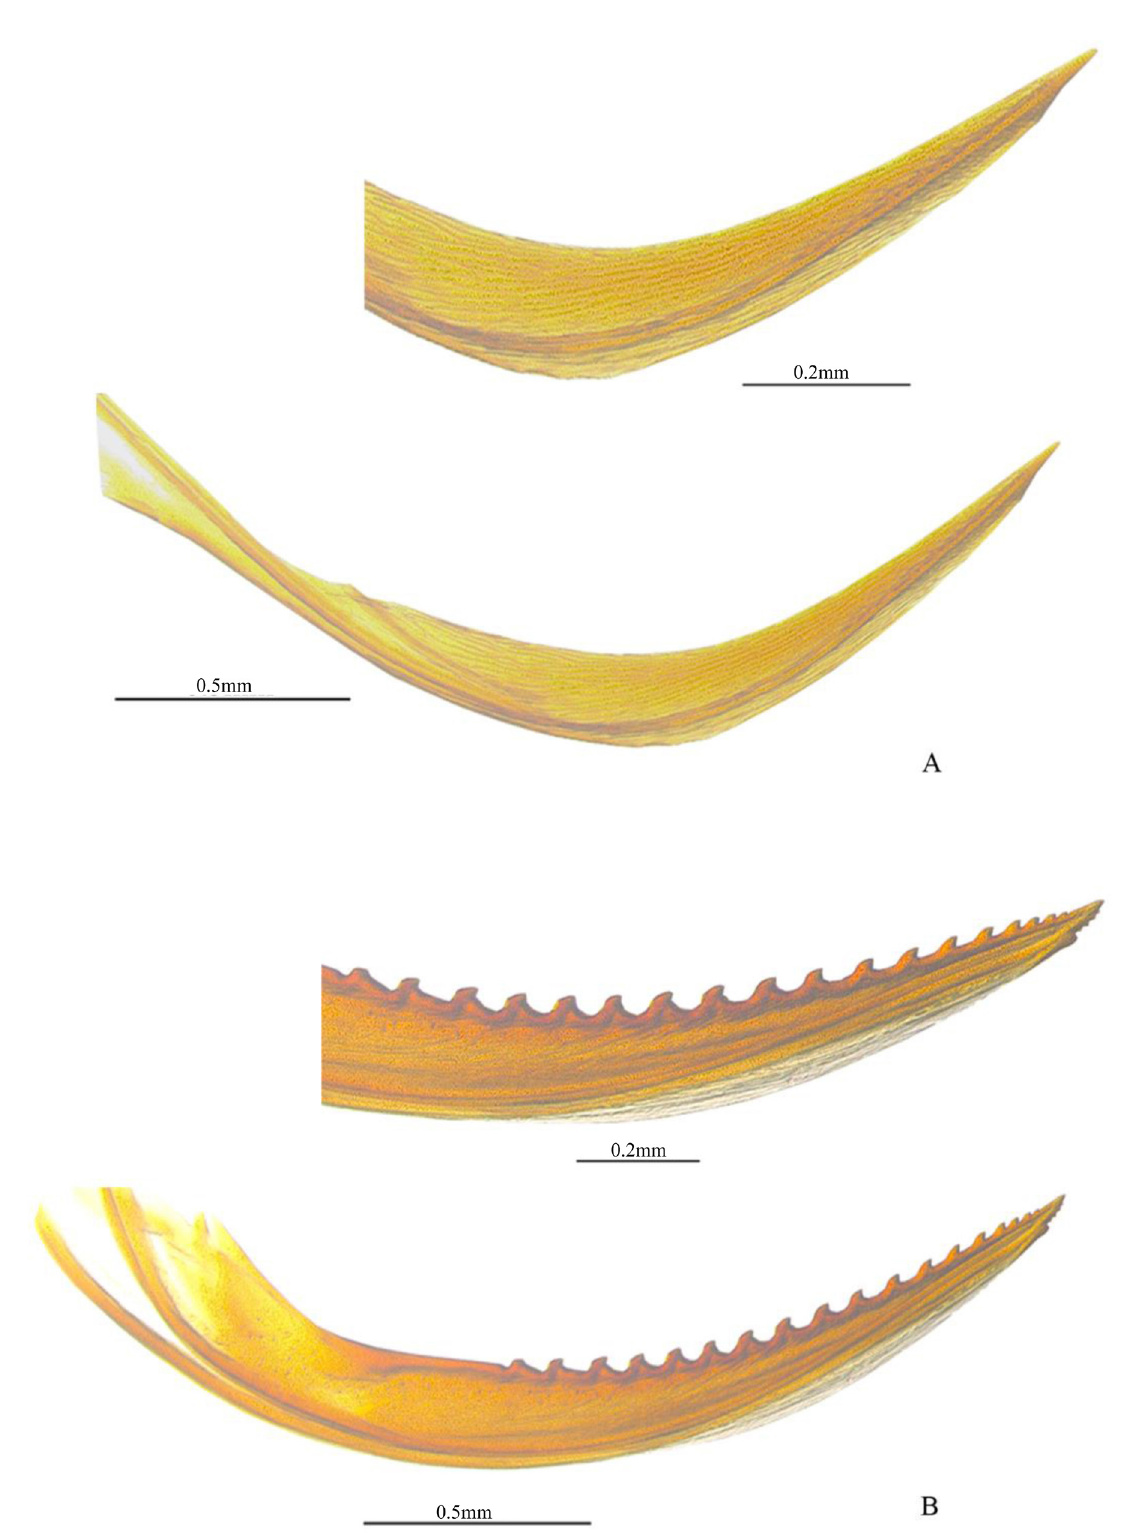
Fig. 5. Eoeurysa sagittaria sp. nov., female genitalia, paratype (NPC HEMT14). A . Valvulae I. B . Valvulae